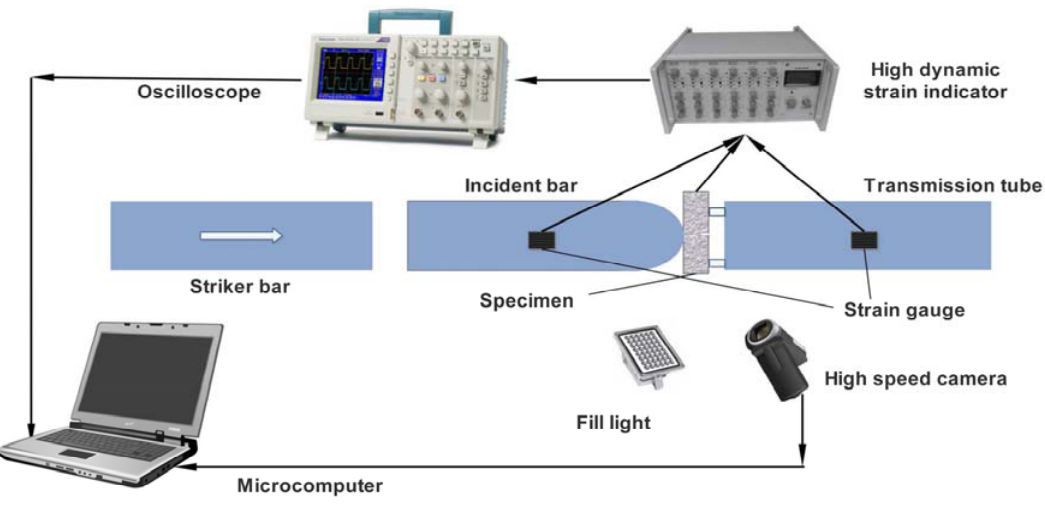
Figure 2. System of split Hopkinson pressure bar (SHPB) loading and data acquisition.